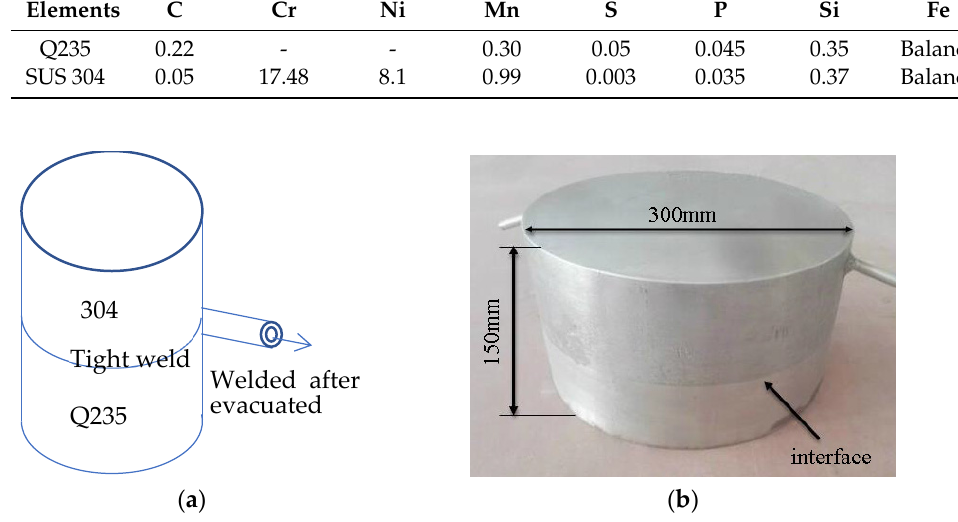
Figure 1. Diagram of sample assembling and bonded ingot. ( a ) Diagram shows the assembly of Q235 and SUS 304; ( b ) press-bonded dissimilar Q235/304 steel ingot after machining; the upper is 304.